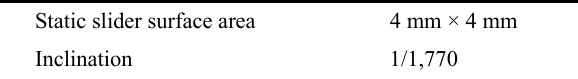
Fig. 10 Pressure distributions at the boundaries. (a) At the side boundary. (b) At the inlet and outlet Table 1 Conditions of the sliding contact.